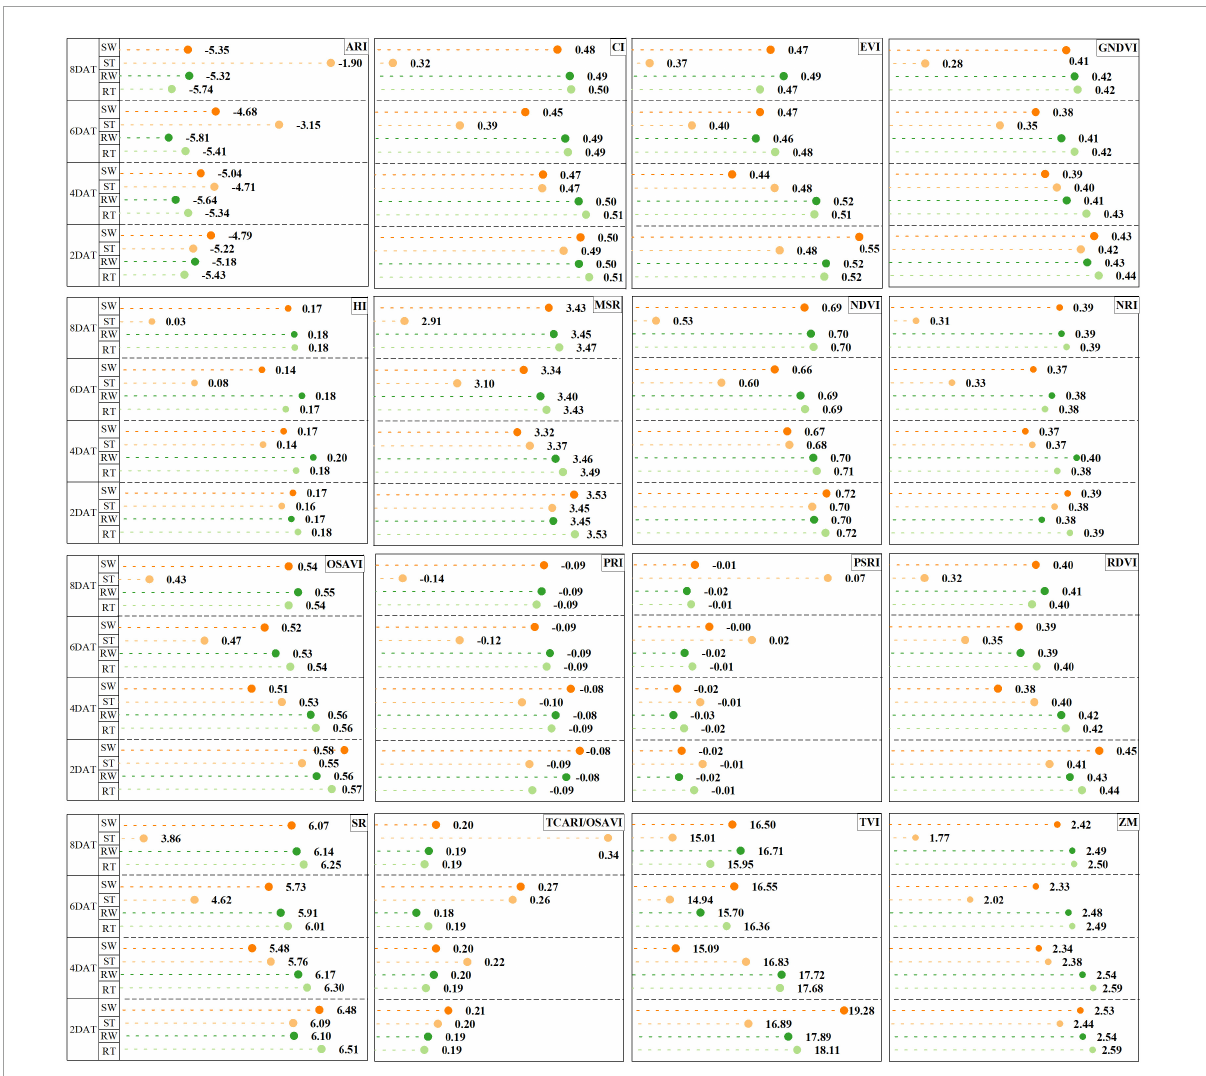
FIGURE6 Time-series effect of glyphosate on the responses of leaf spectral indices at 2, 4, 6, and 8 days after treatment (DAT) in Experiment 1. The spectral index value is presented as means. Letters highlight significant difference among four groups ( p < 0.05) by the Holm-Bonferroni